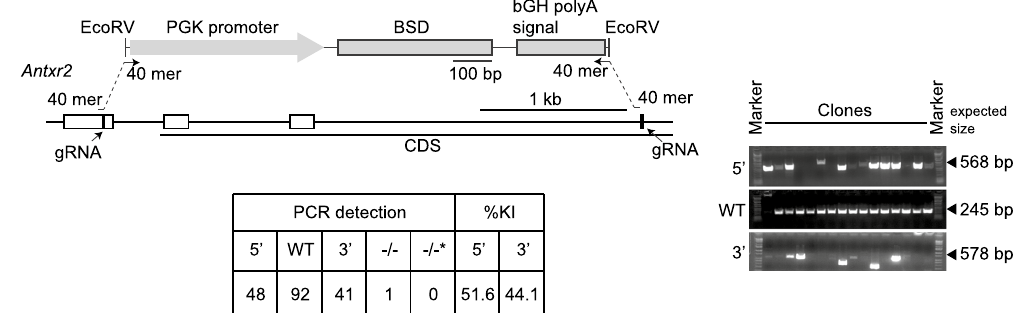
Figure 6. Evaluation of SUCCESS to target Antxr2 in murine ovarian cancer cell line ID8-luc2. The schema of knockout of Antxr2 gene by SUCCESS is shown. Agarose gel images show the genotyping results. The table indicates the genotyping results of 93 clones. 5 ′ , 5 ′ site between the genomic region and the cassette; 3 ′ , 3 ′ site between the genomic region and the cassette; WT, wild-type allele; −/−, homozygously knockout clones: −/−*, homozygously knockout clones without the detection of 5 ′ or 3 ′ sites ligation between the genomic region and the cassette; %KI, percentage of knock-in in 93